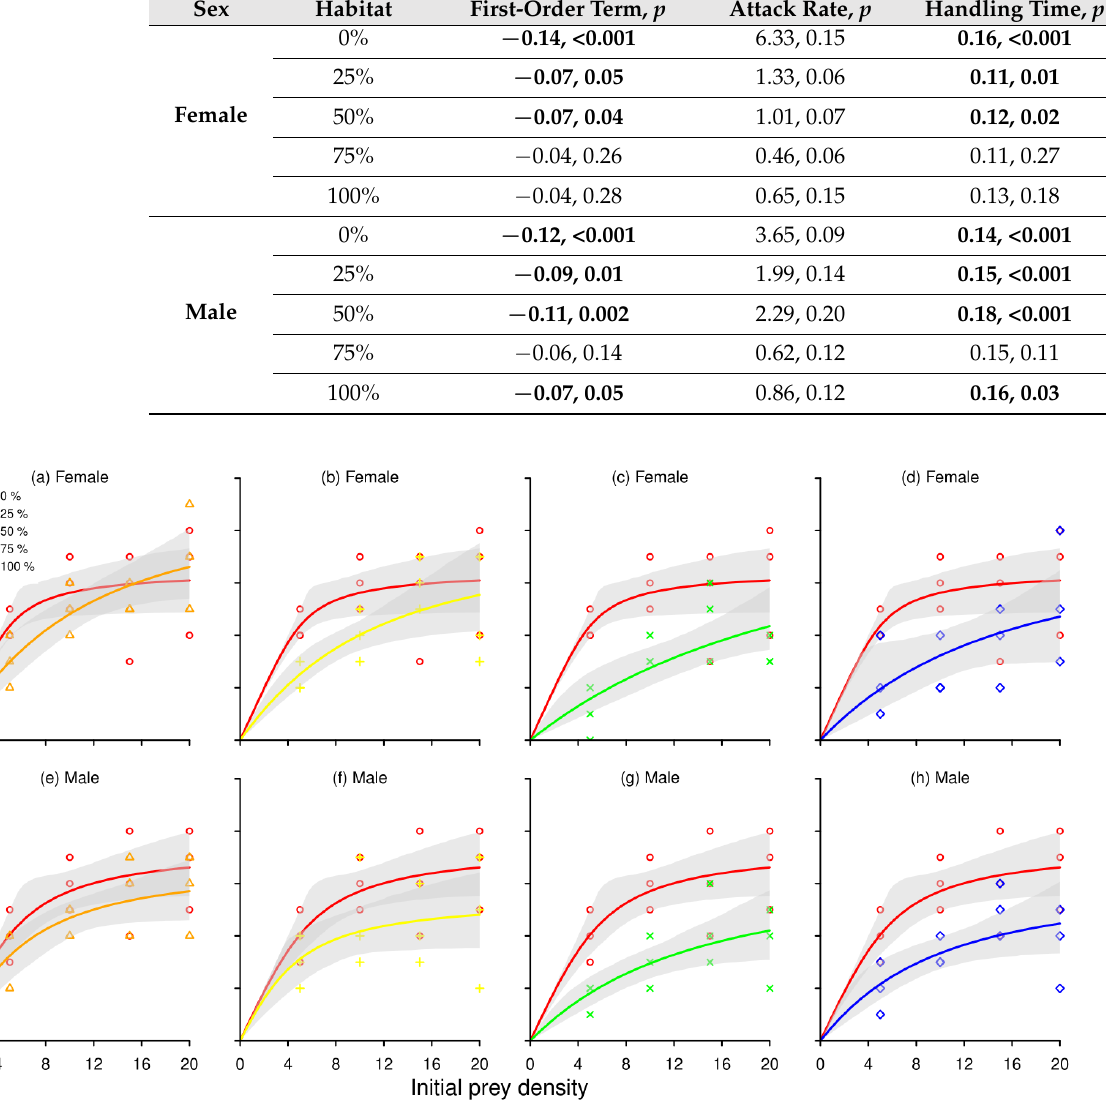
Figure 2. Functional responses of Mesopodopsis wooldridgei across sex (female: ( a – d ); male: ( e – h )) and habitat complexity (25%: ( a , e ); 50%: ( b , f ); 75%: ( c , g ); 100%: ( d , h )) treatments. Functional responses at 0% complexity are always presented with greater habitat levels. Shaded areas are bootstrapped 95% confidence intervals, and points are raw data. Densities correspond to individuals per arena (2 L volume).